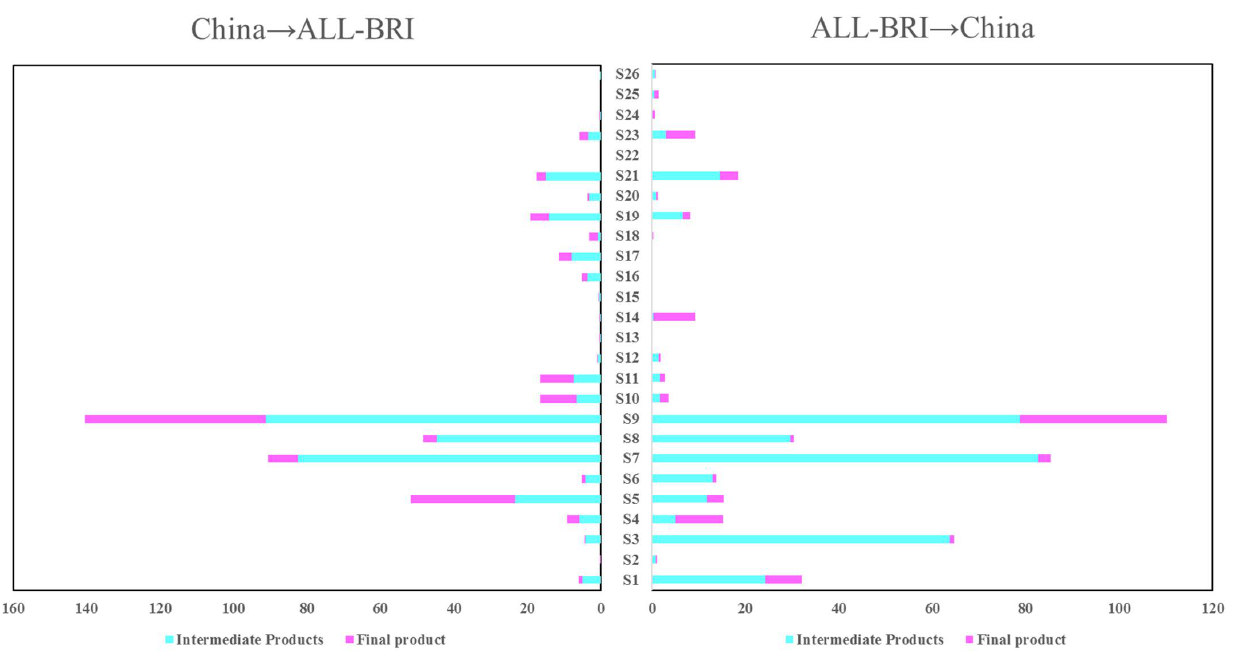
Figure 1. Trade of products between China and BRI countries (US$